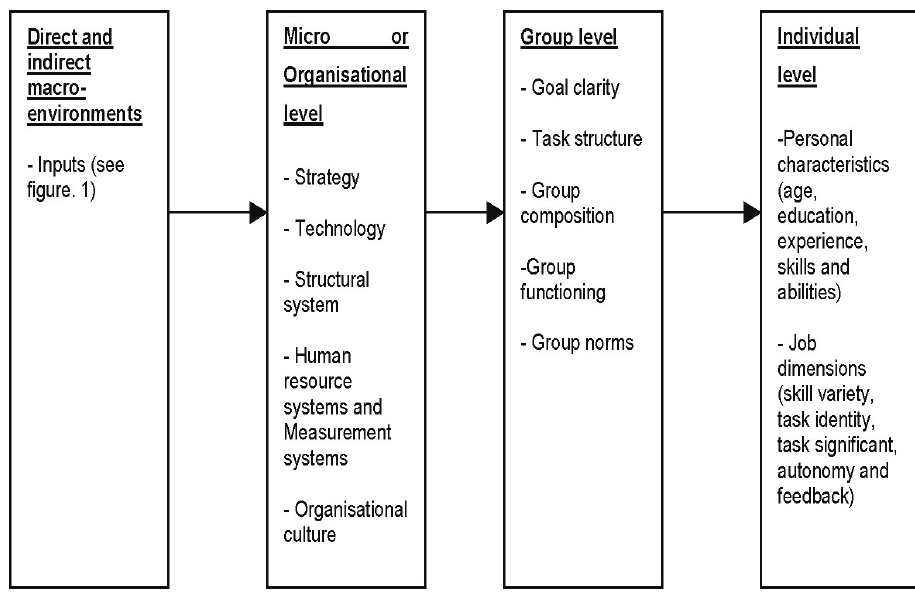
Source: Adapted from Cummings and Worley,